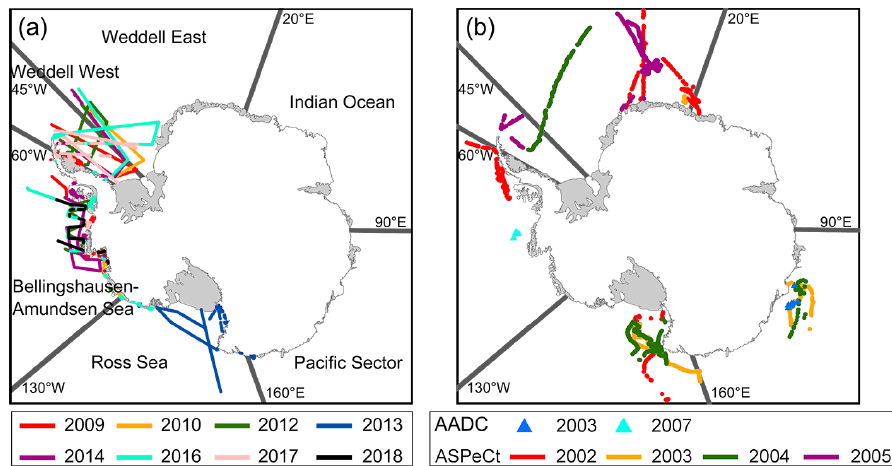
Figure 1. The spatial–temporal distributions of the used OIB airborne measurements (a) . AADC in situ measurements and ASPeCt shipborne observations (b) .